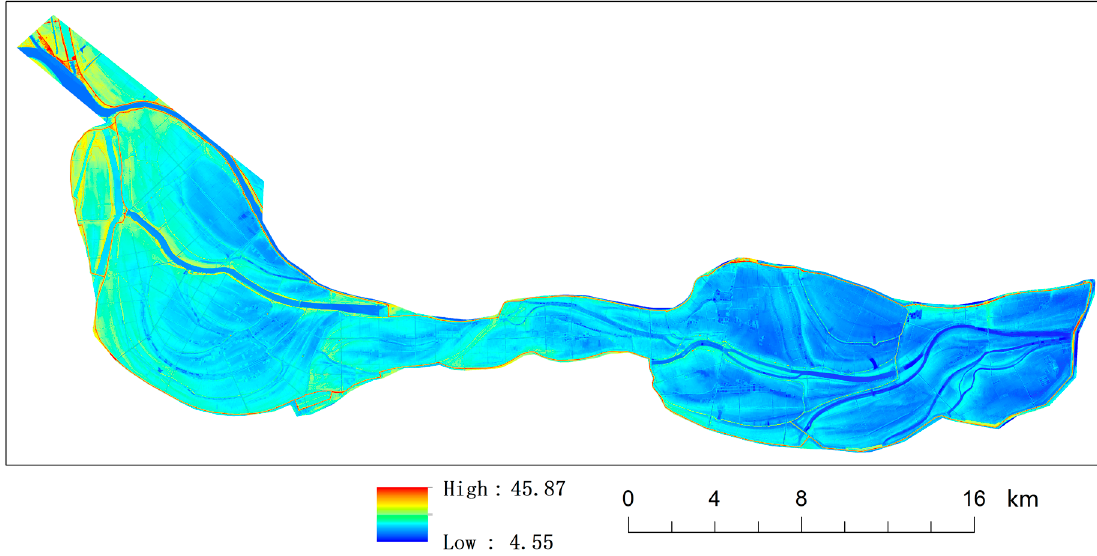
Figure 2. Digital Elevation Model (DEM) data of the Gongshuangcha research area.